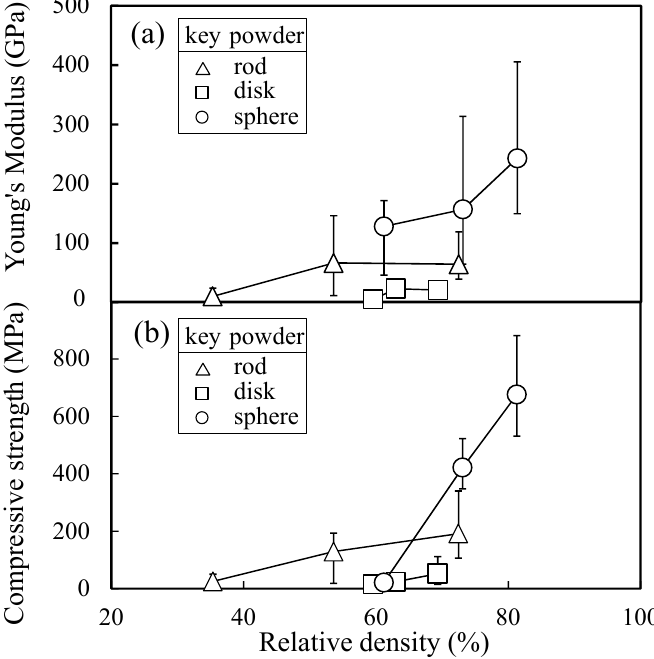
Figure 5. Relation between relative density and ( a ) Young’s modulus or ( b ) compressive strength.